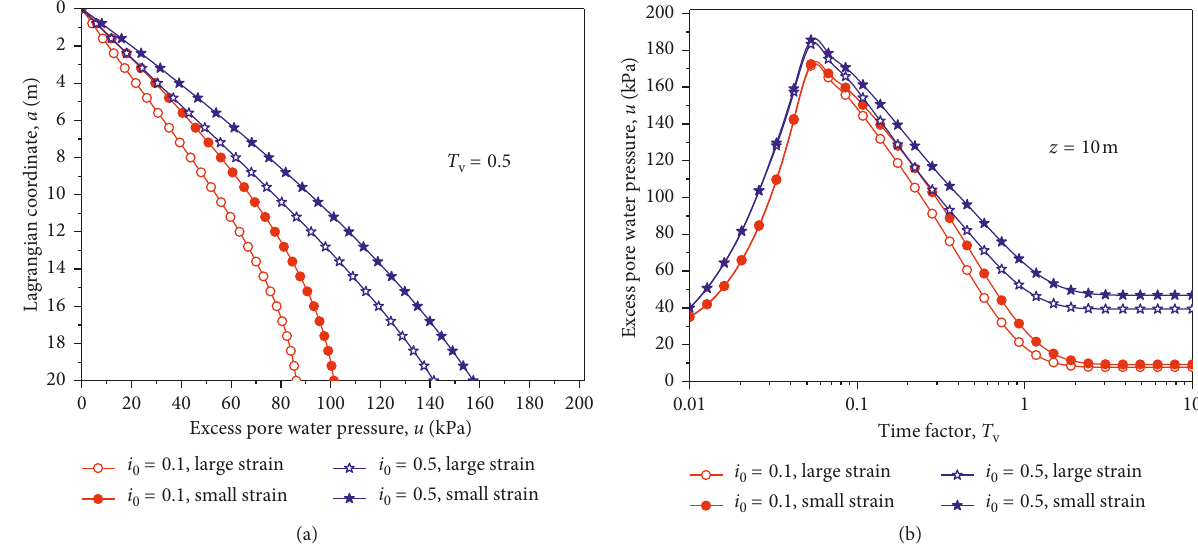
Figure 8: Influences of geometric suppositions on the dissipation of excess pore water pressure. (a) Curves of excess pore water pressure versus Lagrangian coordinate a when T v � 0.5. (b) Curves of excess pore water pressure versus time factor T v at z � 10m.